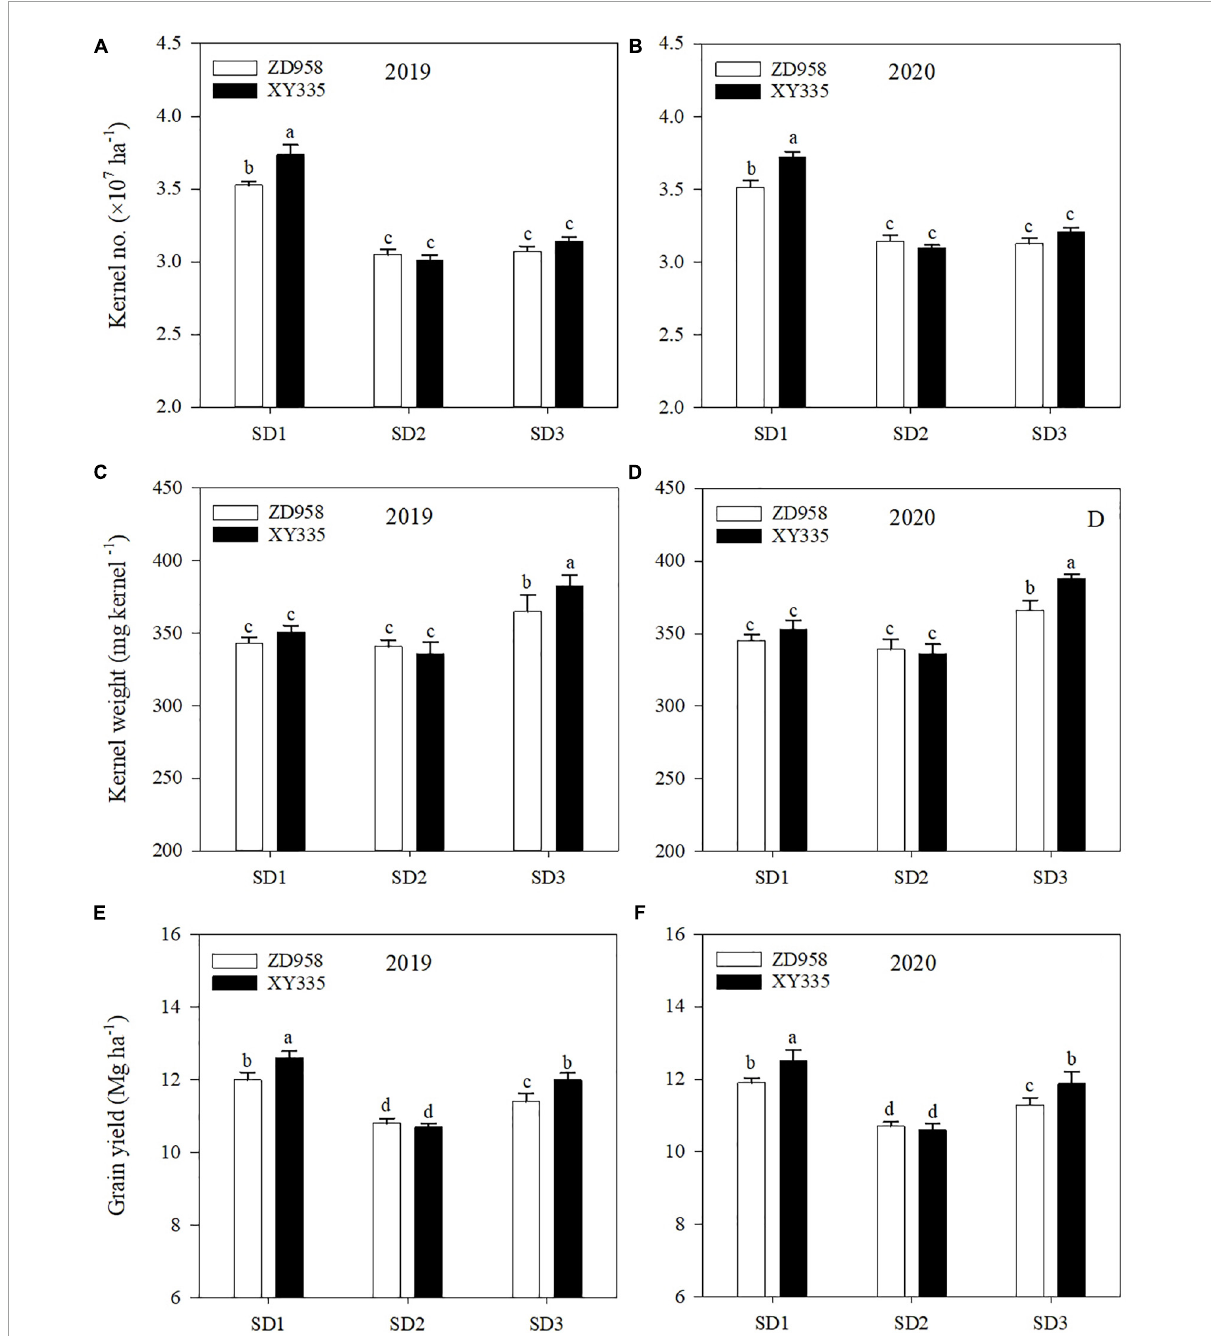
FIGURE4 Kernel number (A,B) , kernel weight (C,D) , and grain yield (E,F) of maize under different sowing dates in 2019 and 2020. SD1, early sowing; SD2, conventional sowing; SD3, delay sowing. Different letters above the error bars indicate significant difference at the 0.05 probability